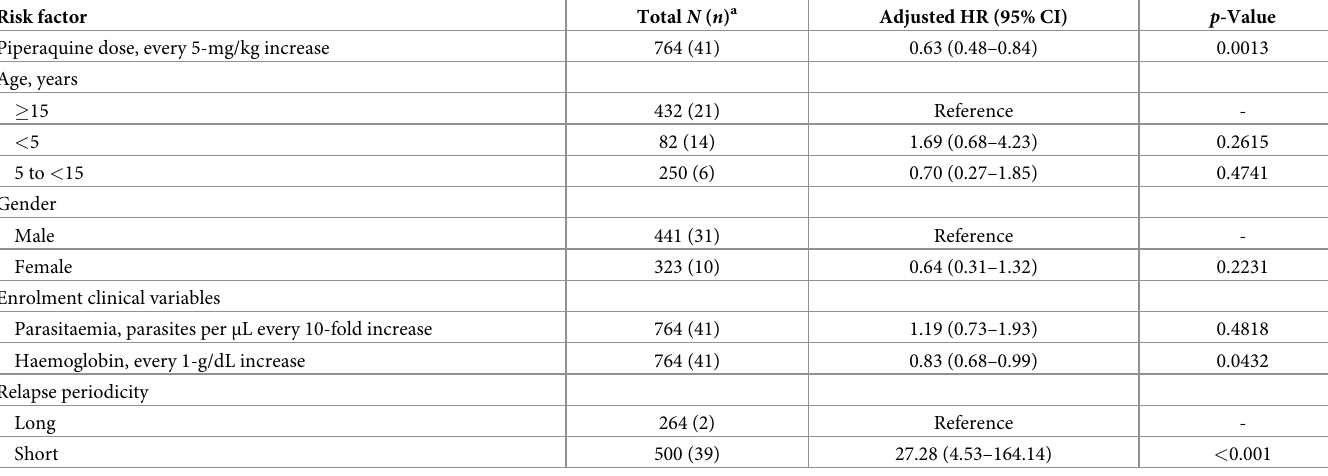
Table 2. Risk factors for P . vivax recurrence between days 7 and 42 in patients treated with dihydroartemisinin-piperaquine alone. Risk